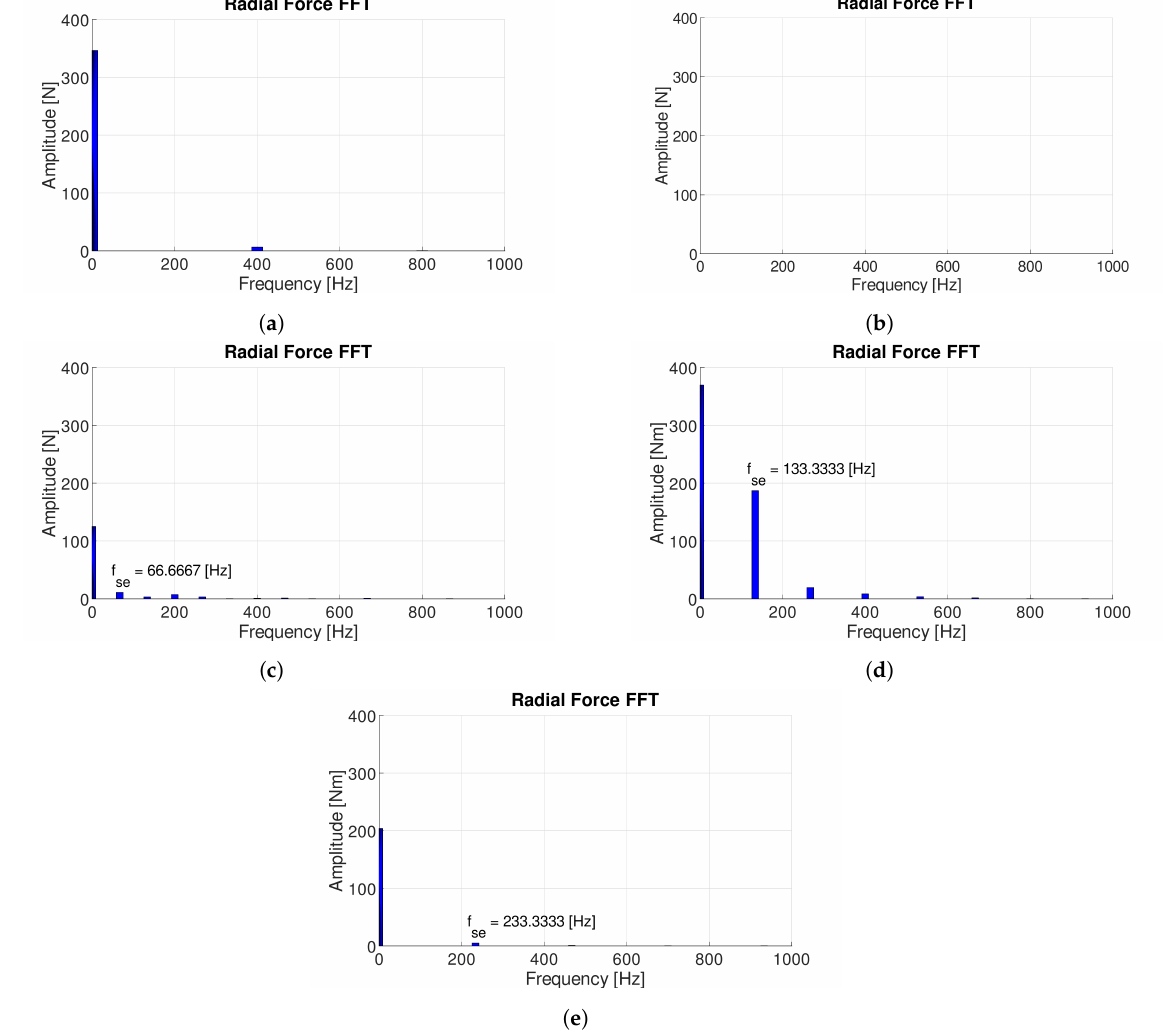
Figure 4. FFT of the radial forces: 9-8DL ( a ); 6-4DL and 12-14DL slot-pole combination without static eccentricity ( b ); 6-4DL ( c ); 9-8DL ( d ); 12-14DL slot-pole combinations with static eccentricity of 0.2 mm ( e